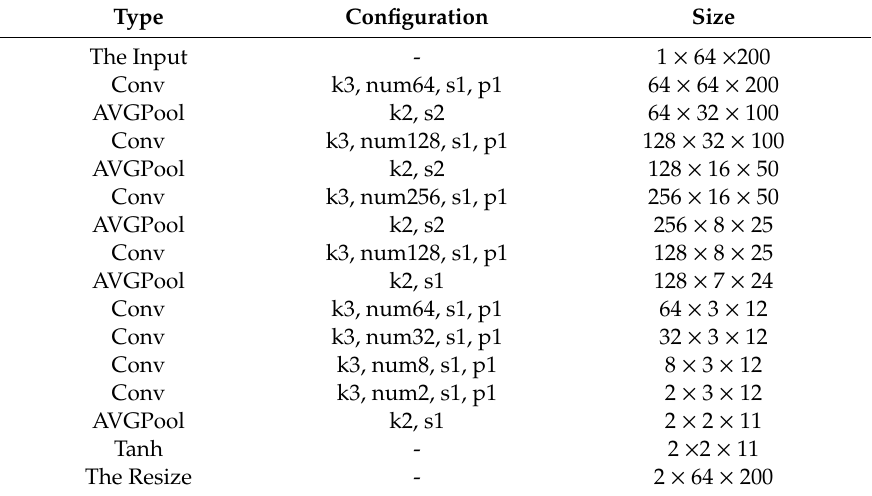
Table 1. Detailed structure of TPC module.